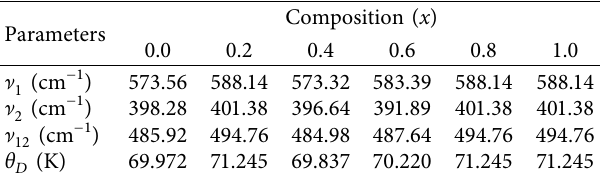
1 − x Ni x Fe 2 O 4 (where